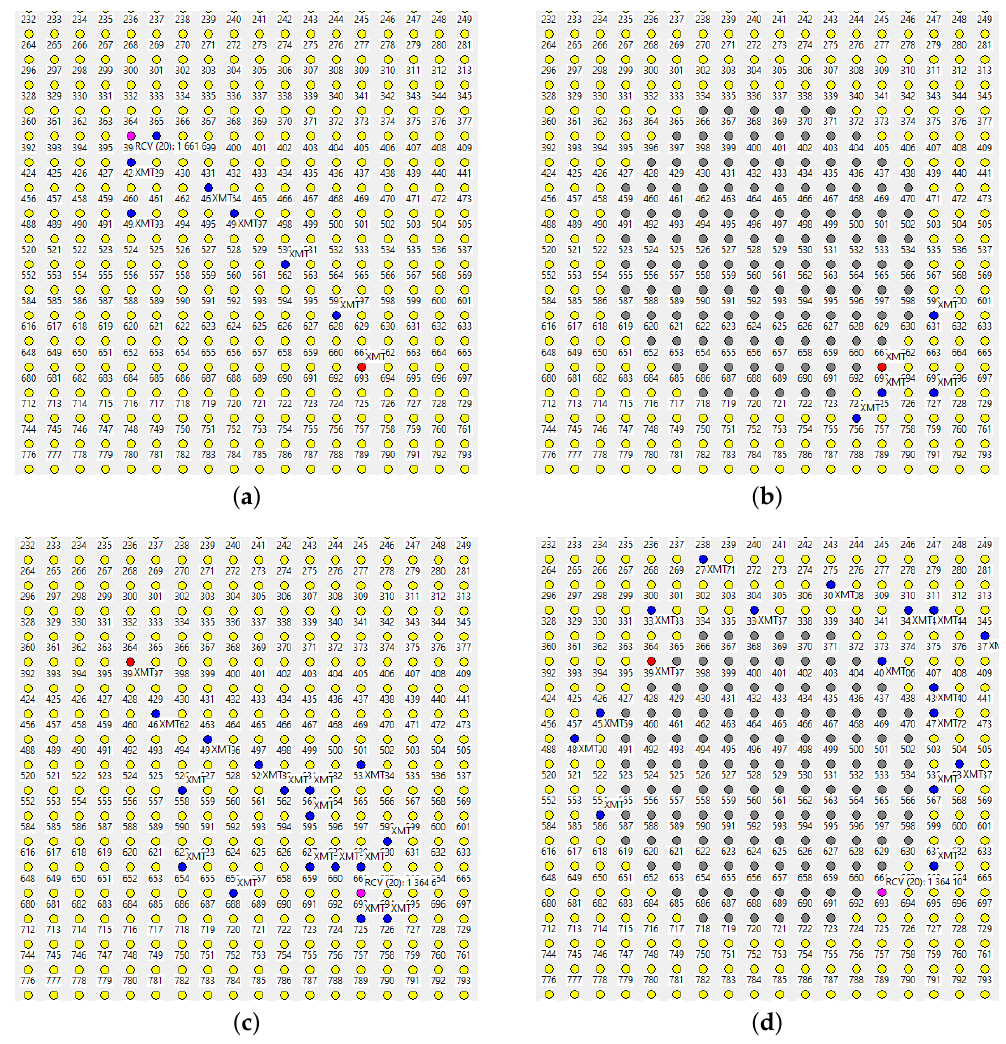
Figure 13. An RPC scenario with local and global relaxation options, C = 2. ( a ) Local variant, no jamming; ( b ) local variant, jamming; ( c ) global variant, no jamming; ( d ) global variant,